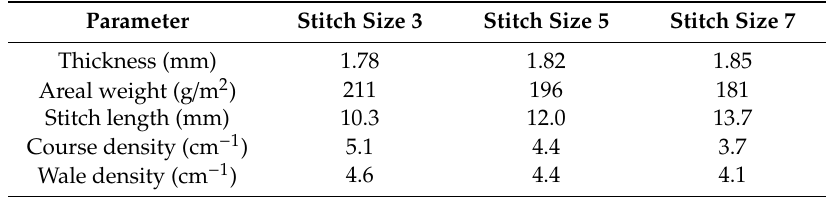
Table 1. Parameters of the knitted fabric used in this